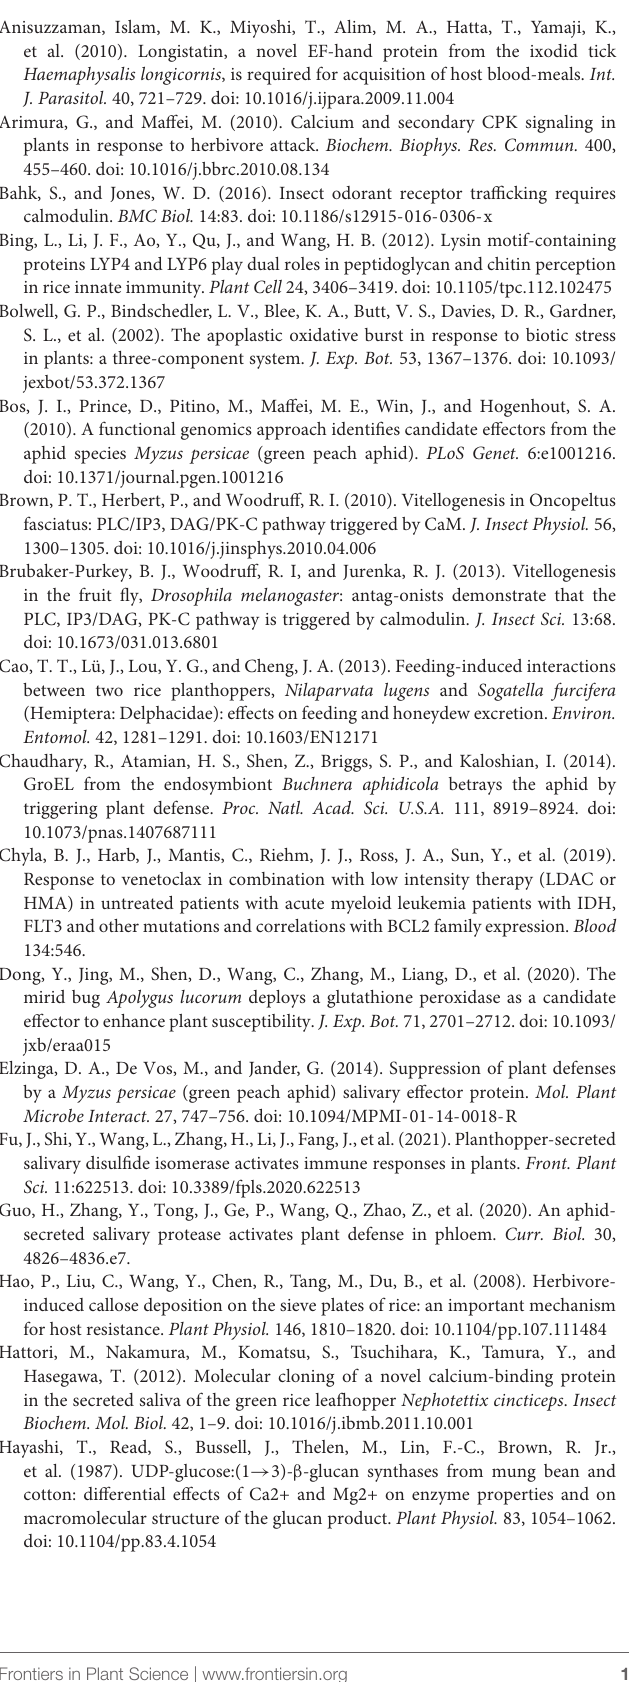
Frontiers in Plant Science |